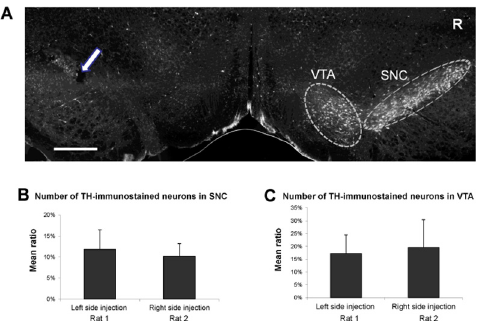
Fig 1. Fluorescent immunostaining of α -tyrosine hydroxylase (TH) in substantia nigra pars compacta (SNC) and ventral tegmentum area (VTA) of two rats injected with 6-OHDA. (A) Digital photograph illustrating typical TH immunostaining obtained in SNC and VTA of a rat injected on the left side: the place reached by the extremity of the 6-OHDA cannula is shown by an arrow. TH immunostaining is much weaker on the left side than on the right side indicated by letter R (Scale bar: 800 μ m). (B), (C) Graphs giving the mean number (in %) of TH-immunostained neurons per SCN (B) and per VTA (C) between injected side and opposite side. The number of TH-immunostained neurons was measured on both sides for each brain coronal sections containing the SNC and/or the VTA and a ratio was calculated. Then for each nucleus, the mean percentage was calculated as the mean of ratios of immunostained neuron number. In both nuclei, neuron number is much lower on the injected side than on the other side.